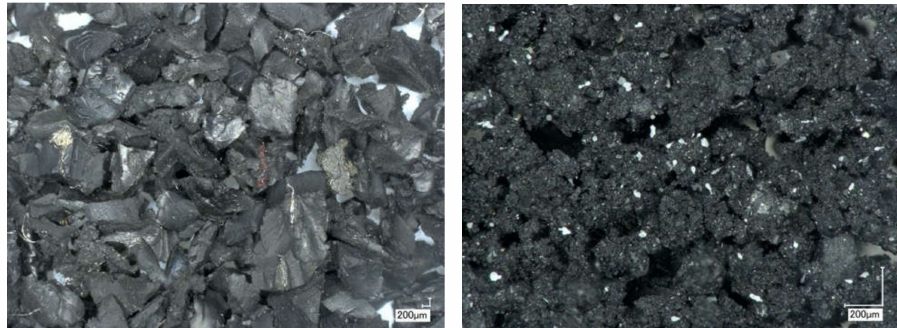
Figure 5. Crumb rubber (left) and devulcanized crumb rubber (right) after mechanochemical processing in a multi-roll system (author’s